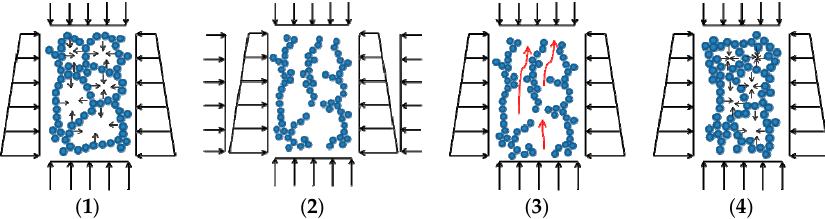
Figure 20. Lateral compressive stress drainage process. ( 1 ) Static equilibrium; ( 2 ) disruption of equilibrium by external compressive stress; ( 3 ) formation of seepage channels; ( 4 ) drainage followed by compaction.